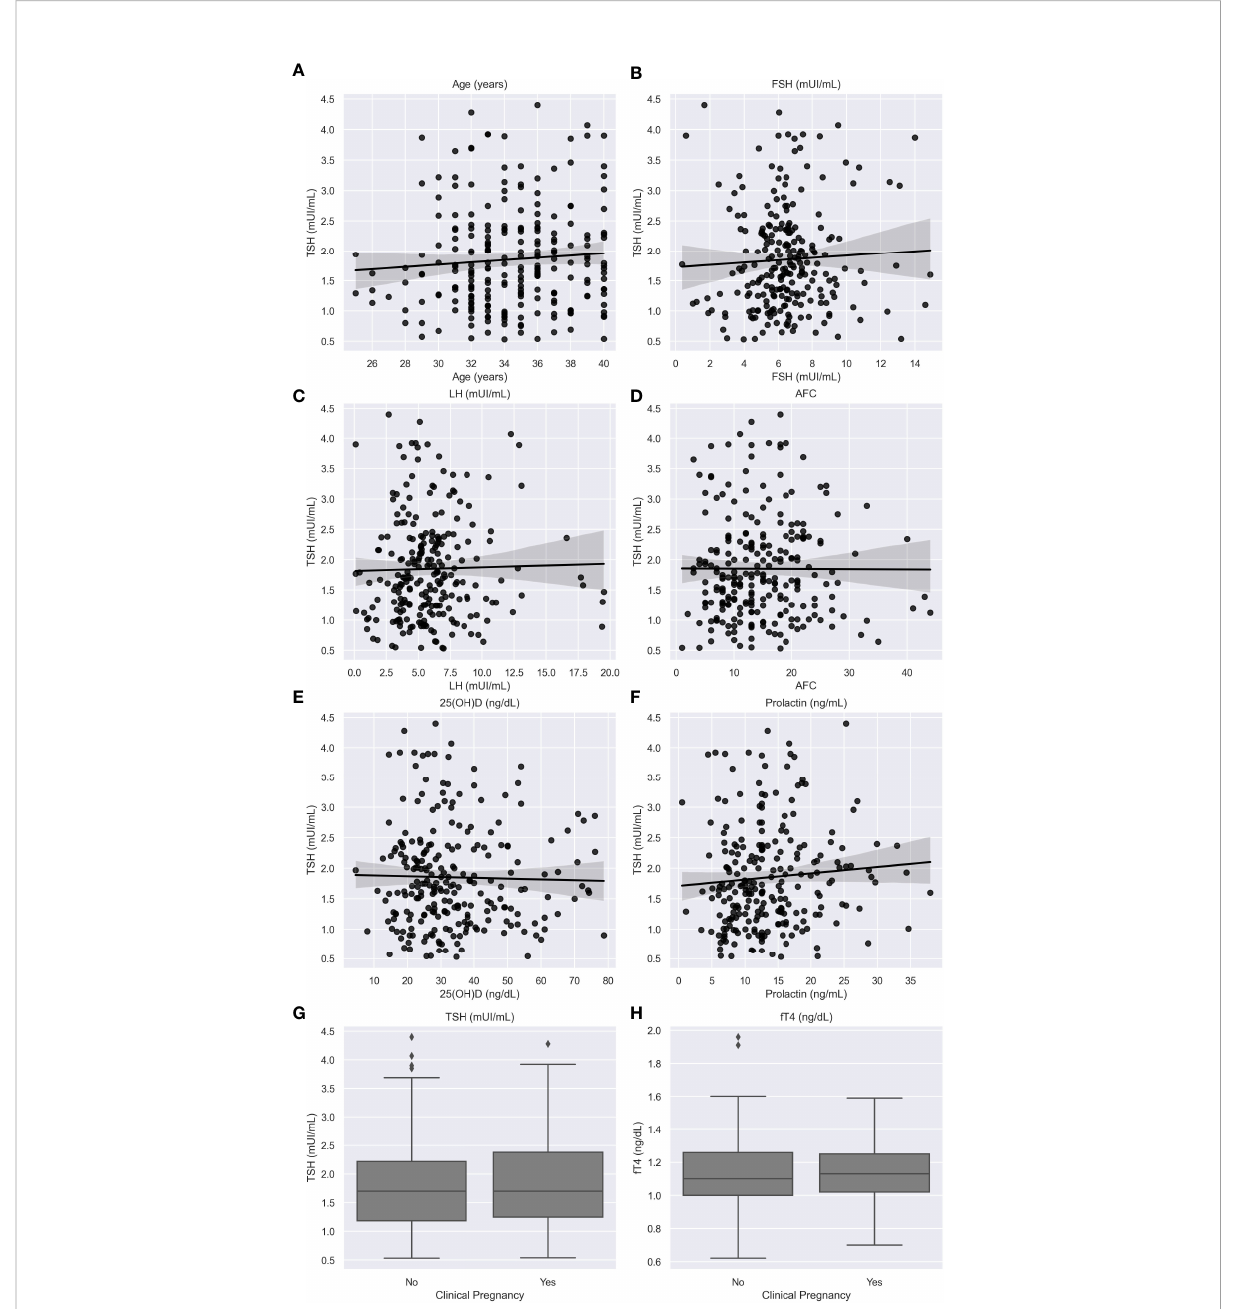
Follicle Count; Follicle-stimulating hormone; FT4: free thyroxine; LH: Luteinizing hormone; TSH: Thyroid stimulating hormone. Black lines mean count and gray area the con fi dence